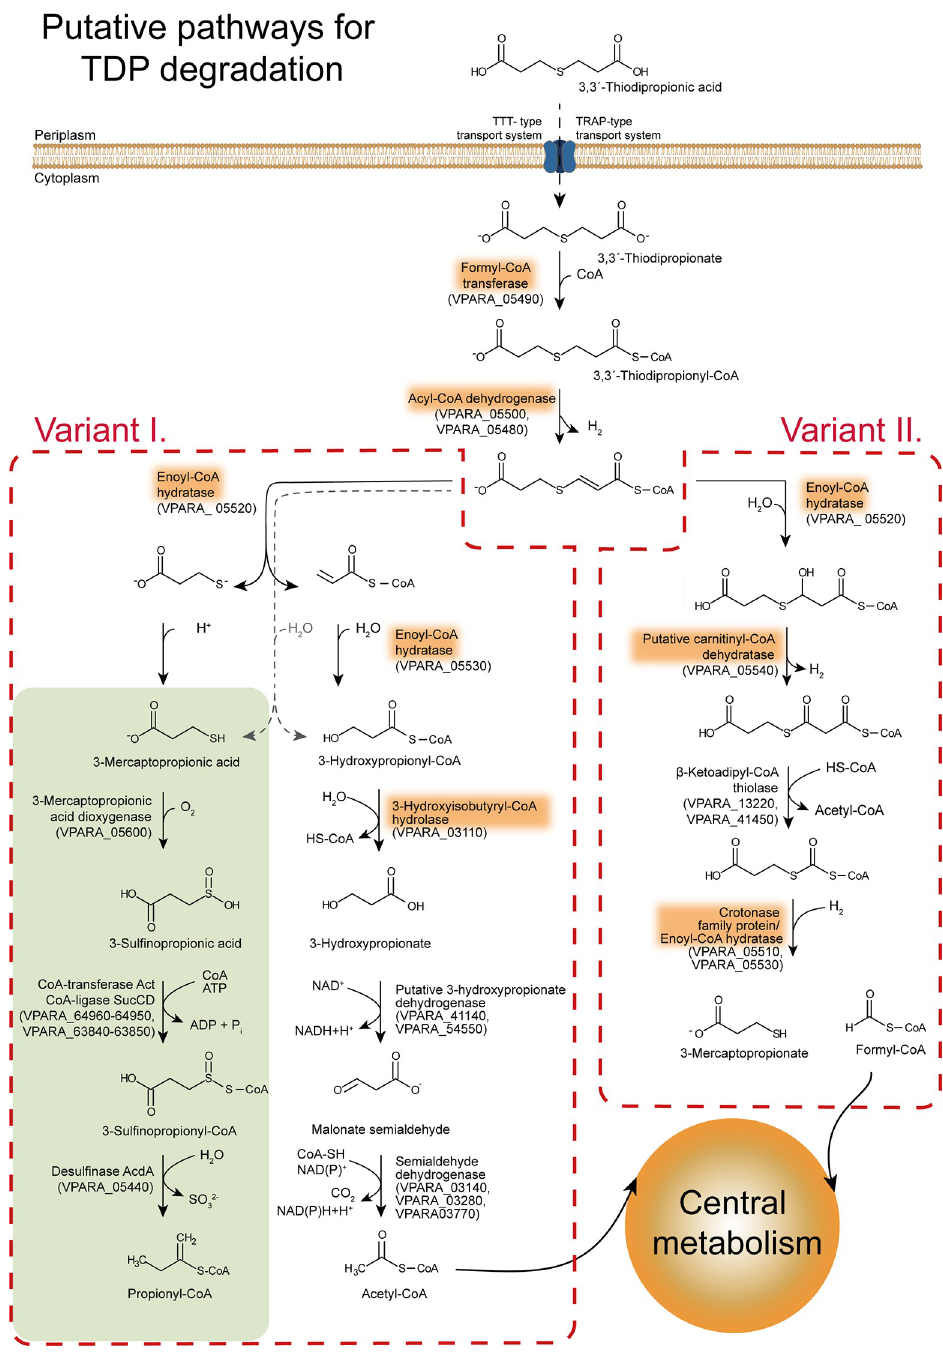
Fig 7. Hypothesis for the degradation of TDP. Possibly, TDP is converted to TDP-CoA by a putative formyl-CoA transferase. Presumably, a double bond is introduced to the molecule after the elimination of two protons by a putative acyl-CoA dehydrogenase. Afterward, two variants of the catabolism were postulated based on the protein profile from the proteome analysis. Variant I.: Degradation of TDP via formation of TDP-CoA and subsequent β -elimination resulting in the formation of acetyl-CoA by the enoyl-CoA hydratase homologs, the crotonase family protein homolog, a putative 3-hydroxypropionic acid dehydrogenase, and a semialdehyde dehydrogenase homolog. Variant II.: Degradation of TDP via β -oxidation resulting in the formation of formyl-CoA and 3-mercaptopropionate by the enoyl-CoA hydratases, a putative carnitinyl-CoA dehydratase, β -keto-thiolase homologs, and a putative crotonase family protein. The already described catabolism of 3-mercaptopropionate is shown in the grey box.